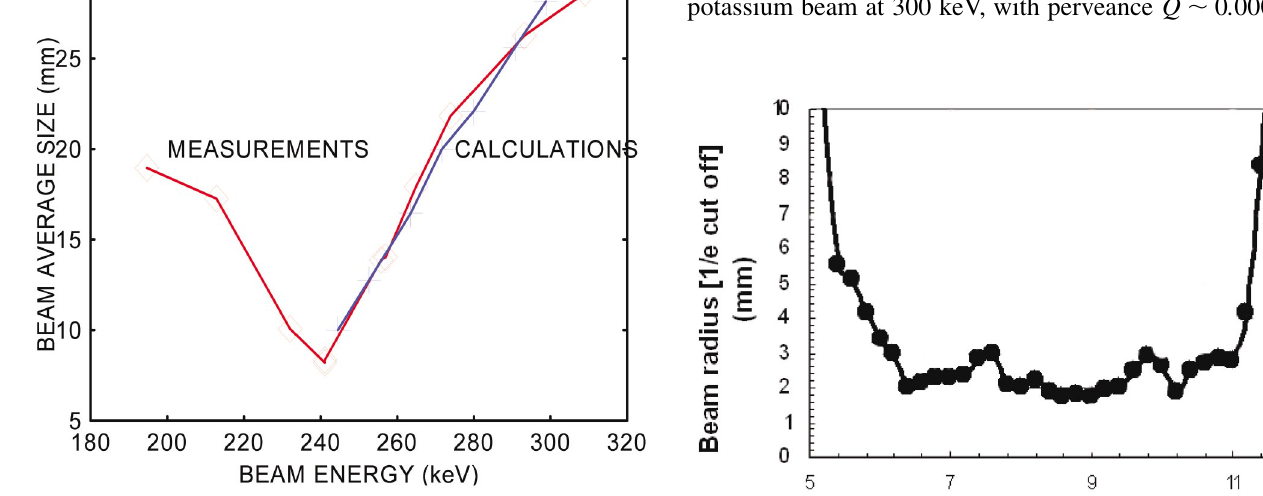
FIG. 11. (Color) Calculated (blue plus sign) and measured (red diamond) beam size at the exit of the final-focus system as the beam energy is varied. A factor of 3% was subtracted from the energy used in the calculation.